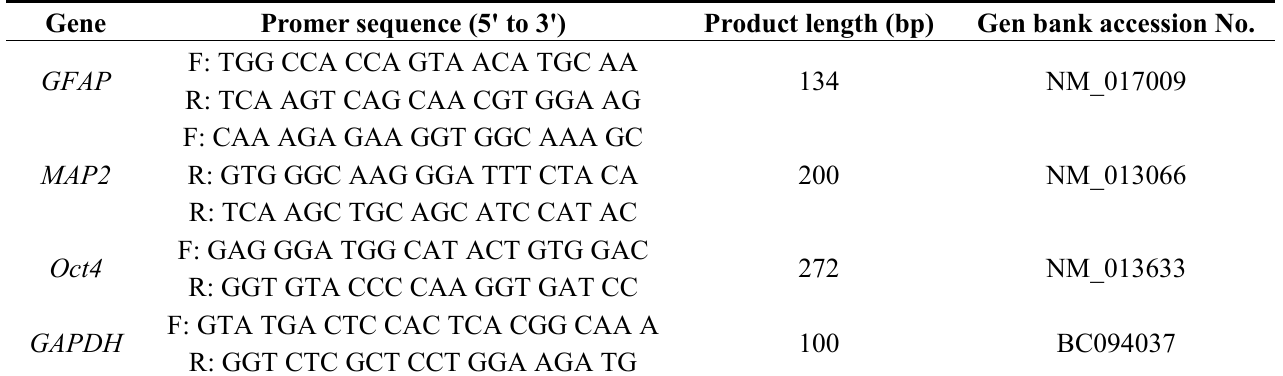
Table 1. Oligonucleotide primers used for